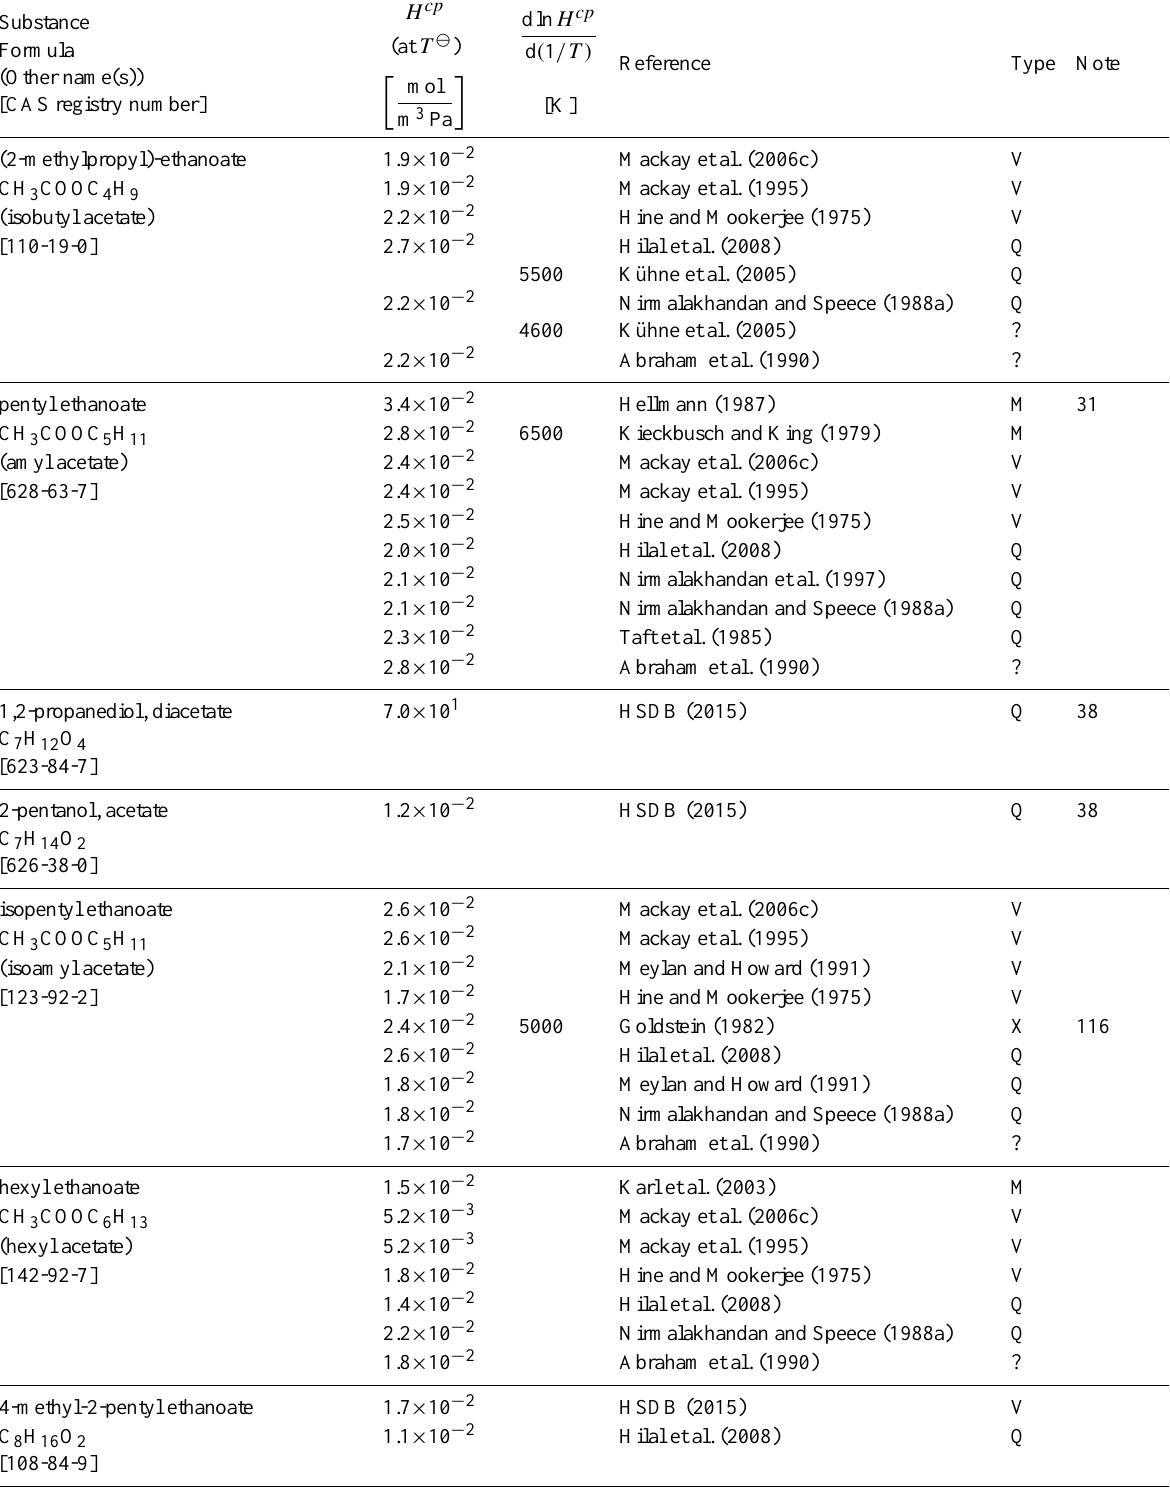
Table 6: Henry’s law constants for water as solvent